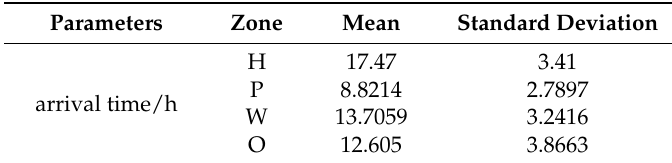
Table 5. Parameters of arrival time.